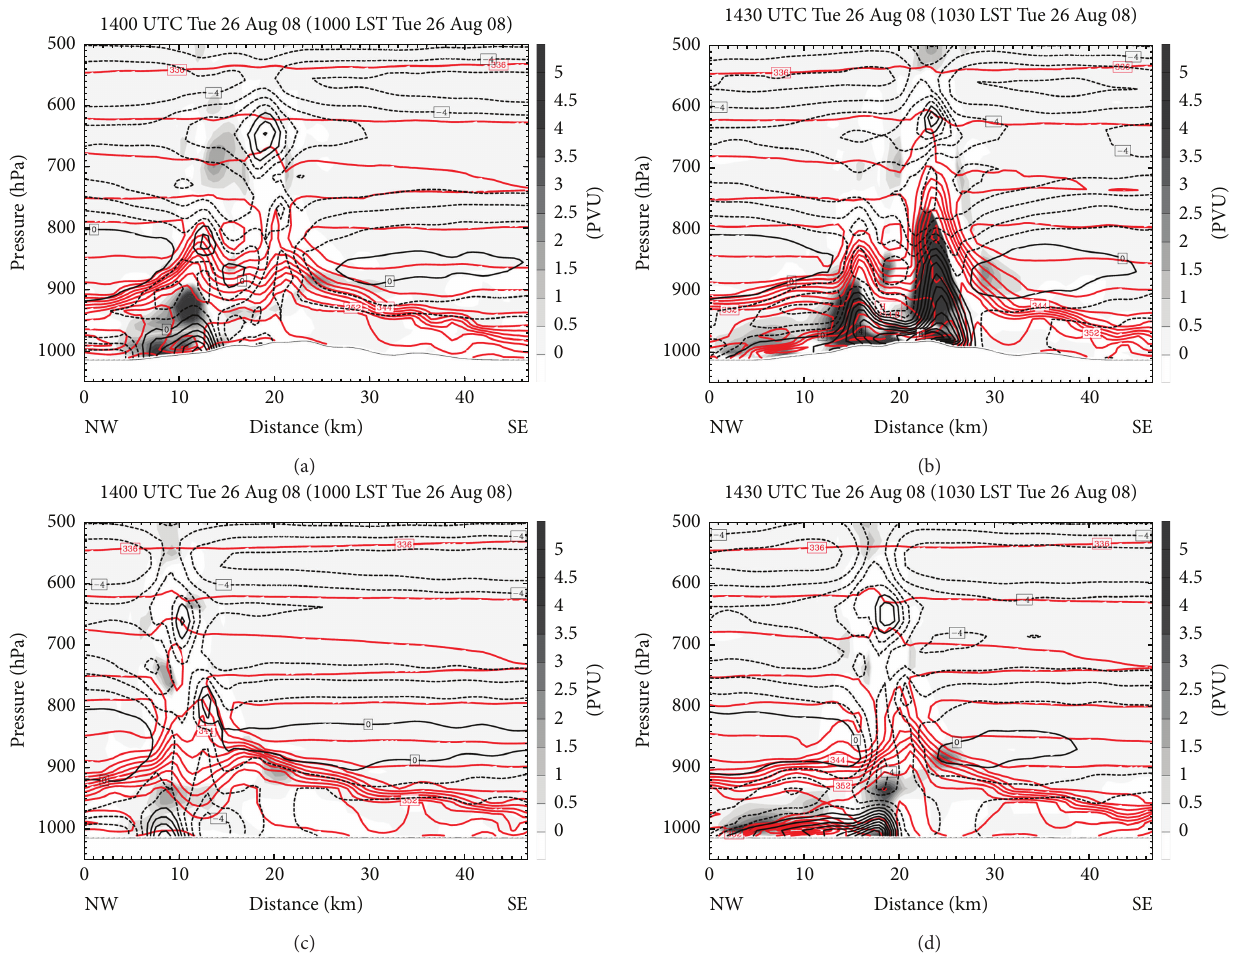
Figure 6: Vertical cross-section (AA 󸀠 ) of zonal wind (black contours), equivalent potential temperature (red contours) and potential vorticity (shaded) valid at (a) 1400 UTC, and (b) 1430UTC for the CTRL experiment; (c) and (d) are for the NOTER